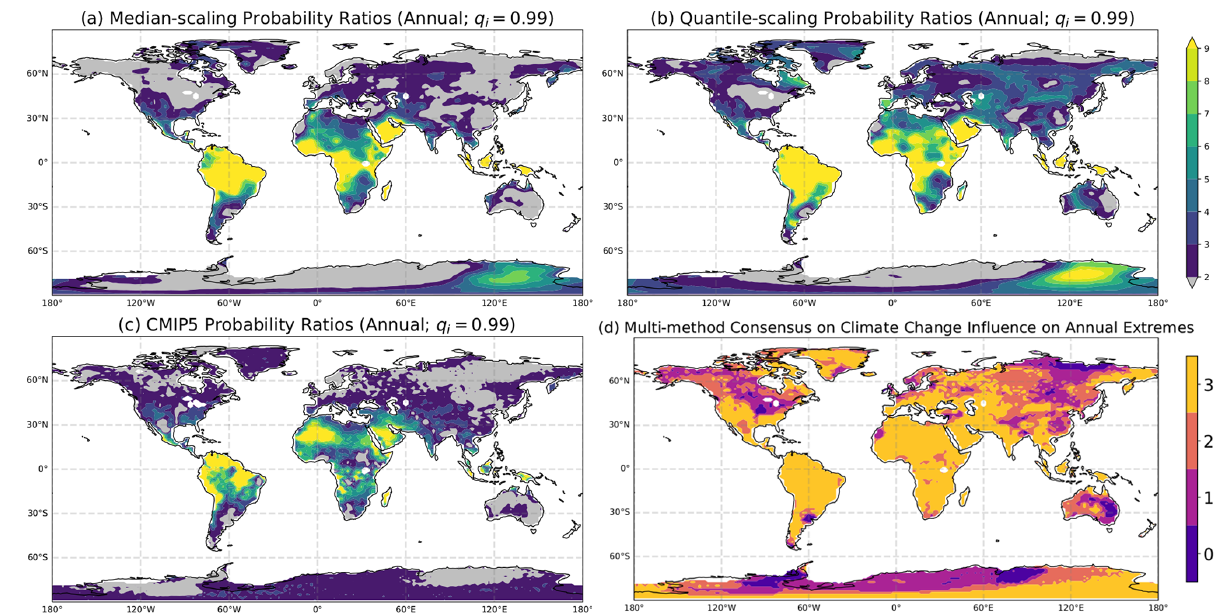
Figure 4. Globally resolved probability ratios (unitless) calculated with the observation-based (a) median-scaling approach, (b) quantile- scaling approach, and from (c) the ensemble mean of the model-based attribution approach. Analyses with PR < 2 are grayed out to em- phasize regions where human influence is most clearly found. (d) Map of the total number of the framework’s attribution methods (derived from panels a–c ) that have PR ≥ 2 at each overland location (total between 0 and 3). PRs are found by comparing mean daily exceedances of the 99th percentile (calculated from the annual counterfactual distribution; see the text) between the full 31-year forced and counterfactual distributions from each